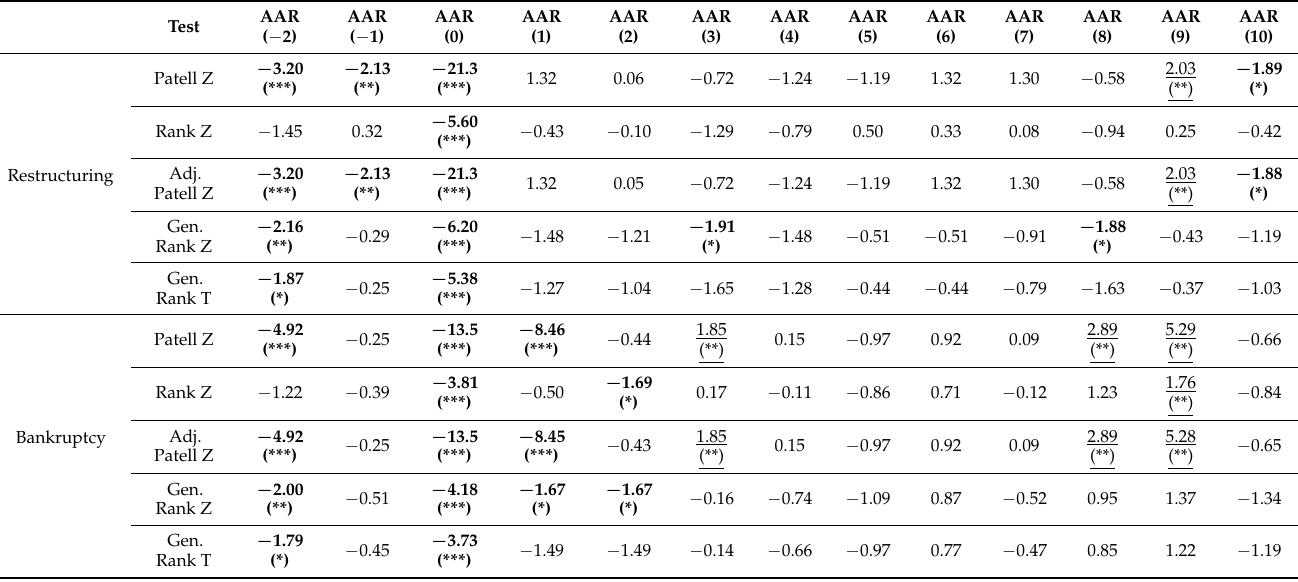
Table 6. Values of test statistics for the performed test (Option